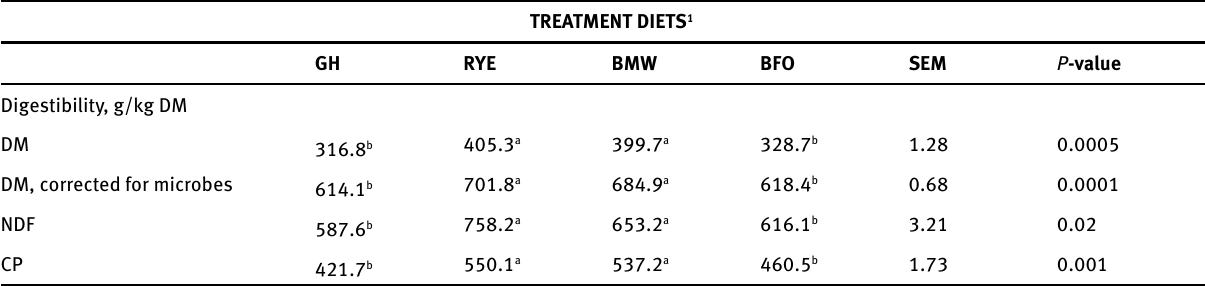
Table 3. Effects of forage oats and forage wheat on the apparent ruminal digestibility of rations designed for developing